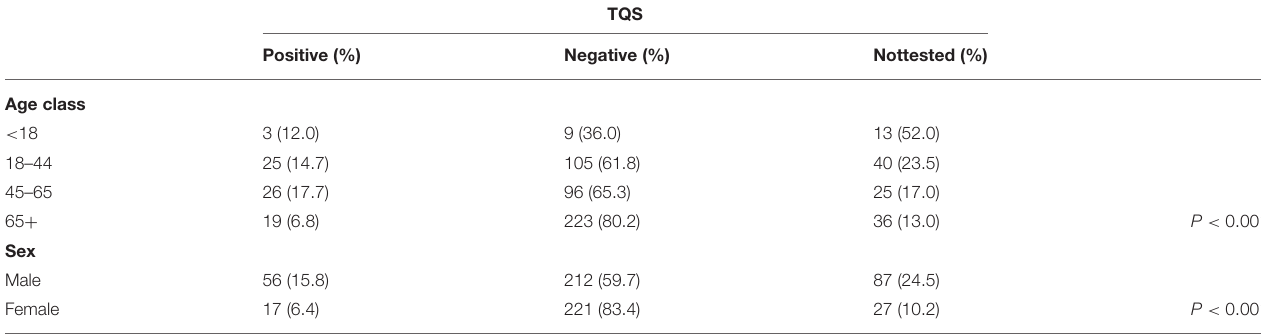
TABLE 3 | Distribution of the TQS test results by age and sex.